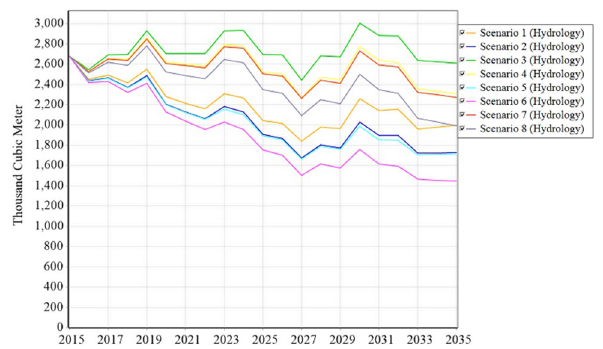
Fig. 7 Variation of water shortage in different scenarios of different drought levels